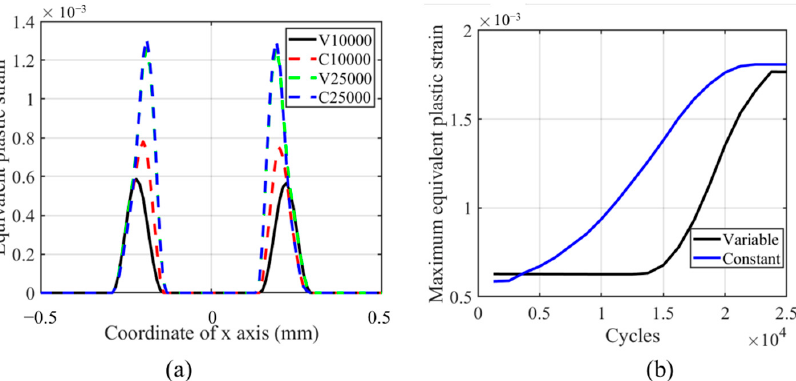
Figure 23. Profile and history of shear and tangential stress for the flat specimen in the partial slip regime for both CWCM and VWCM: ( a ) and ( b ) are shear and tangential stress profiles in 10,000th cycle and 250,000th cycle when 𝛿 = 10 mm, and ( c ) and ( d ) are the history of maximum shear and tangential stress, respectively.